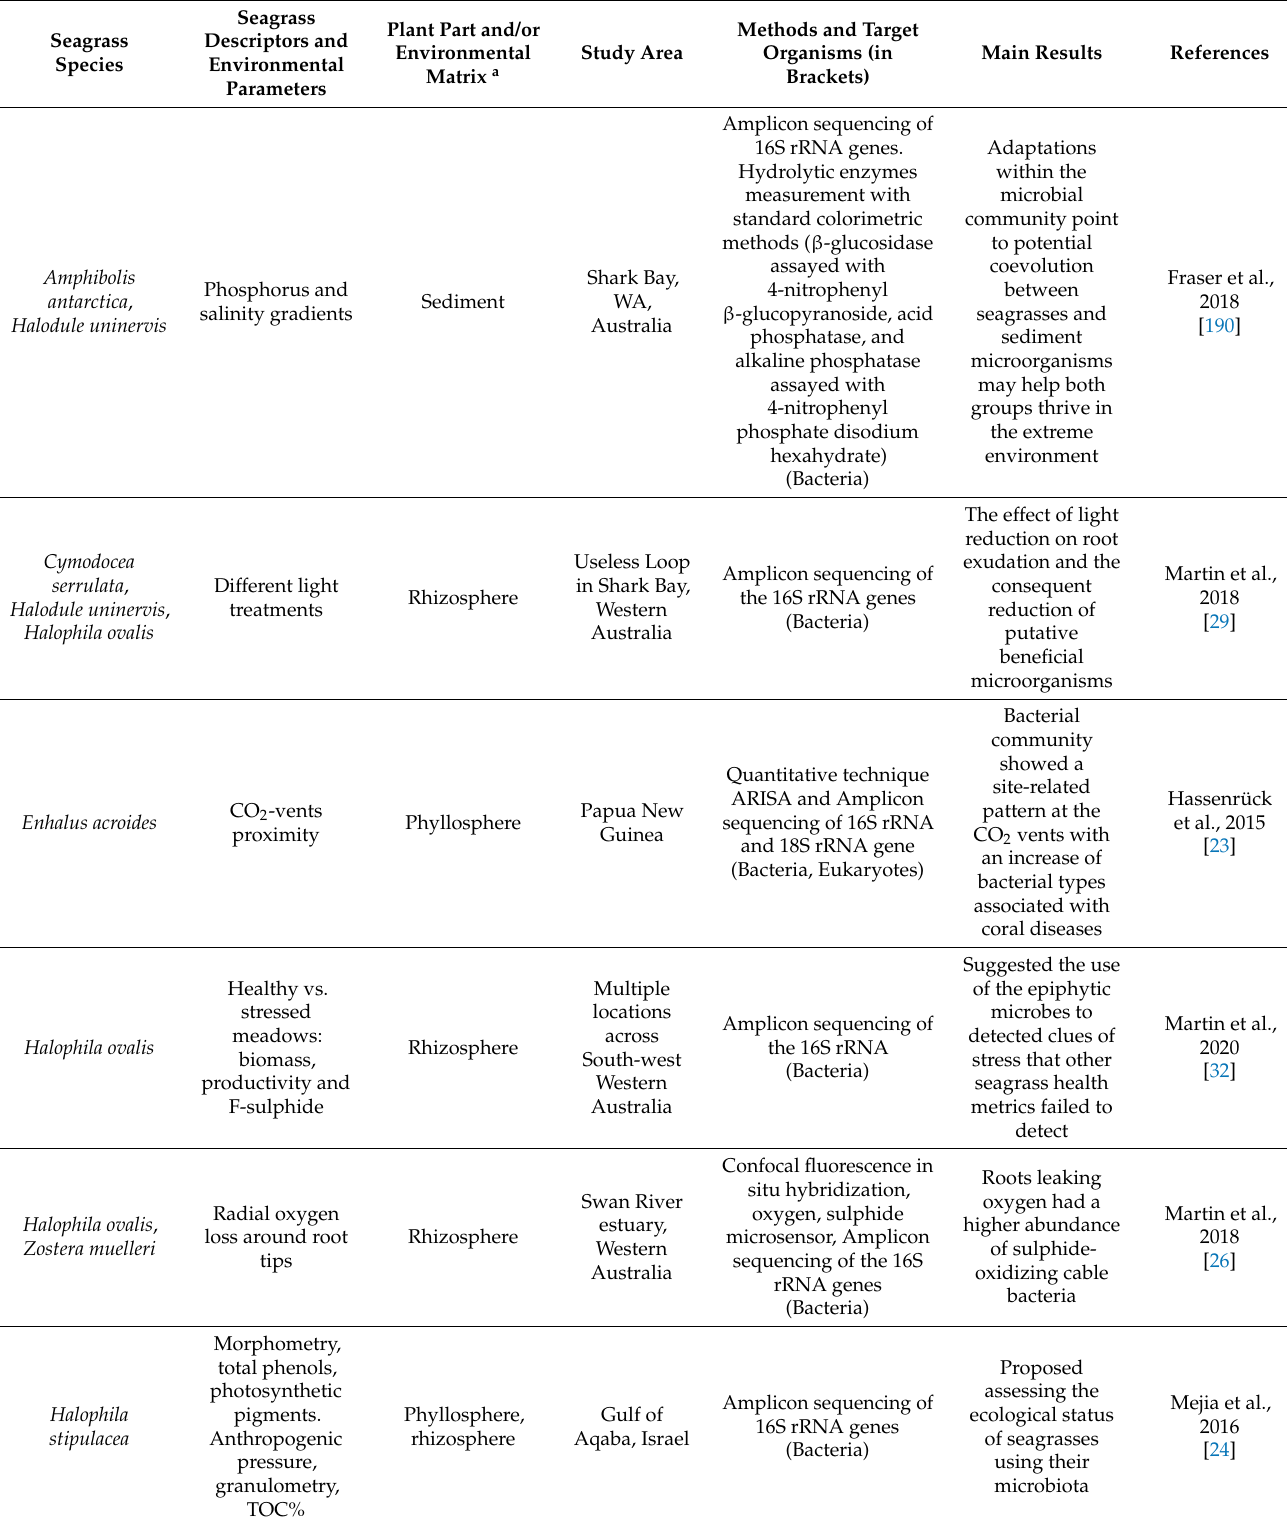
Table 1. Detailed list of studies with insights and attempts of the application of microbes as environmental/seagrass ecological